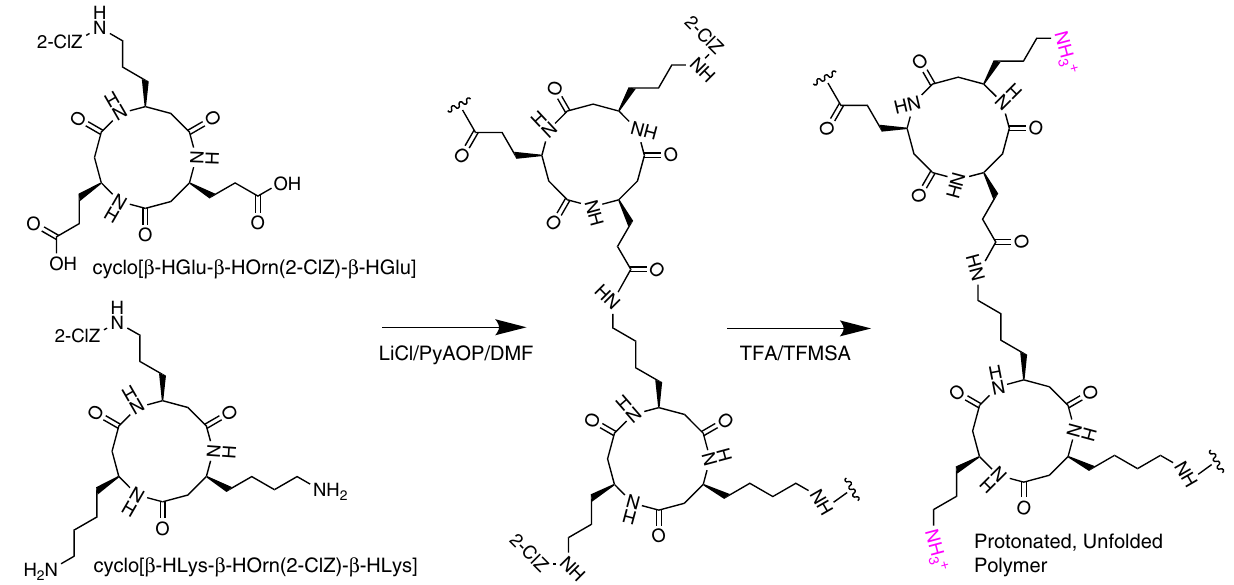
Fig. 2 Cyclic β -tripeptide polymer synthesis scheme. Cyclic peptides were polymerized using the coupling agent (7-azabenzotriazol-1-yloxy) tripyrrolidinophosphonium hexa fl uorophosphate (PyAOP) and fi nal deprotection was performed with a mixture comprising tri fl uoroacetic acid (TFA) and tri fl uoromethane sulfonic acid (TFMSA). Synthesis details are in the Methods section and Supplementary